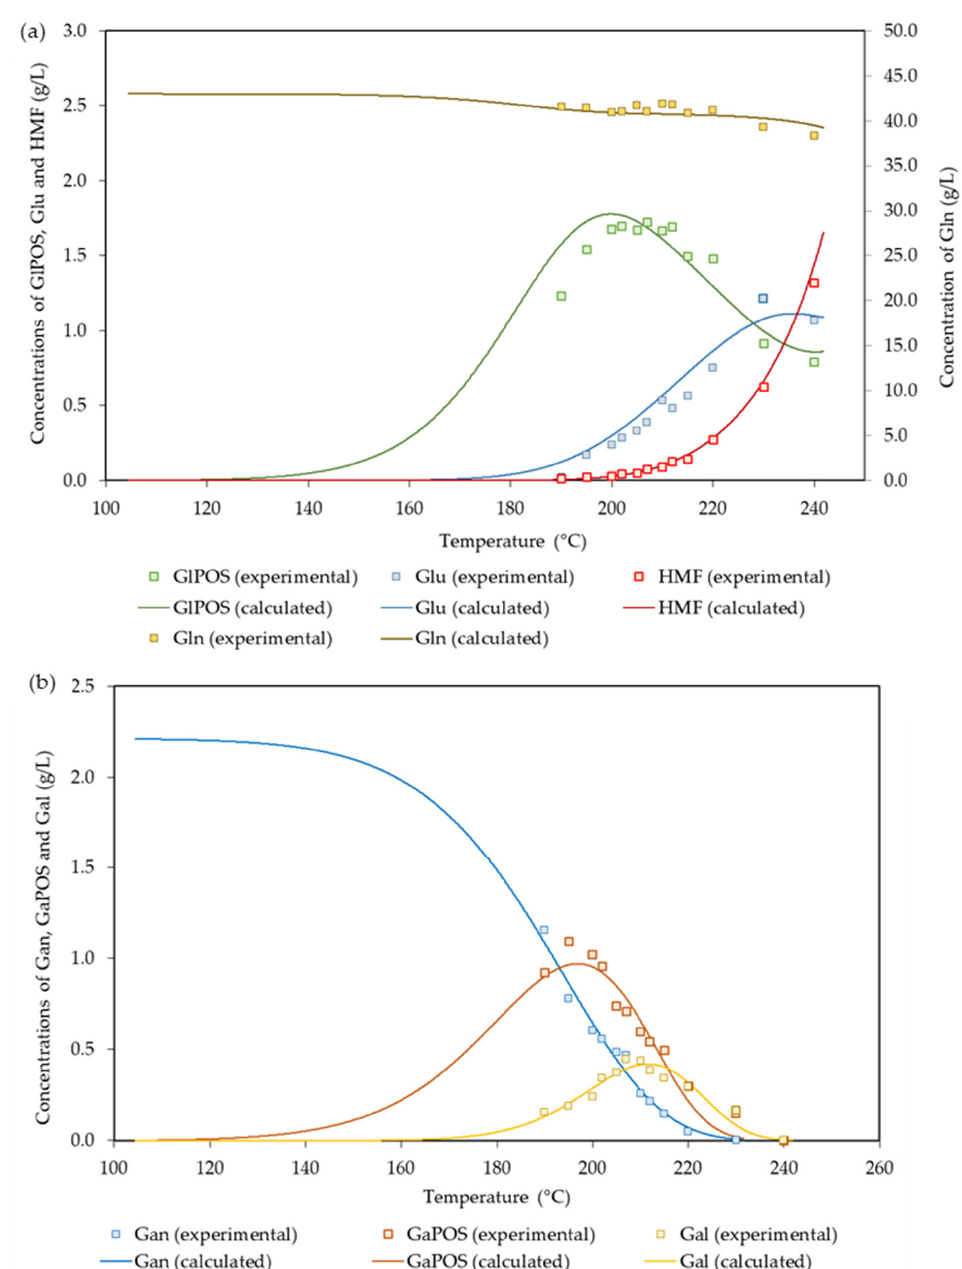
Figure 3. Experimental and calculated values determined for: ( a ) Gl n and the derived products; ( b ) Ga n and the derived products.